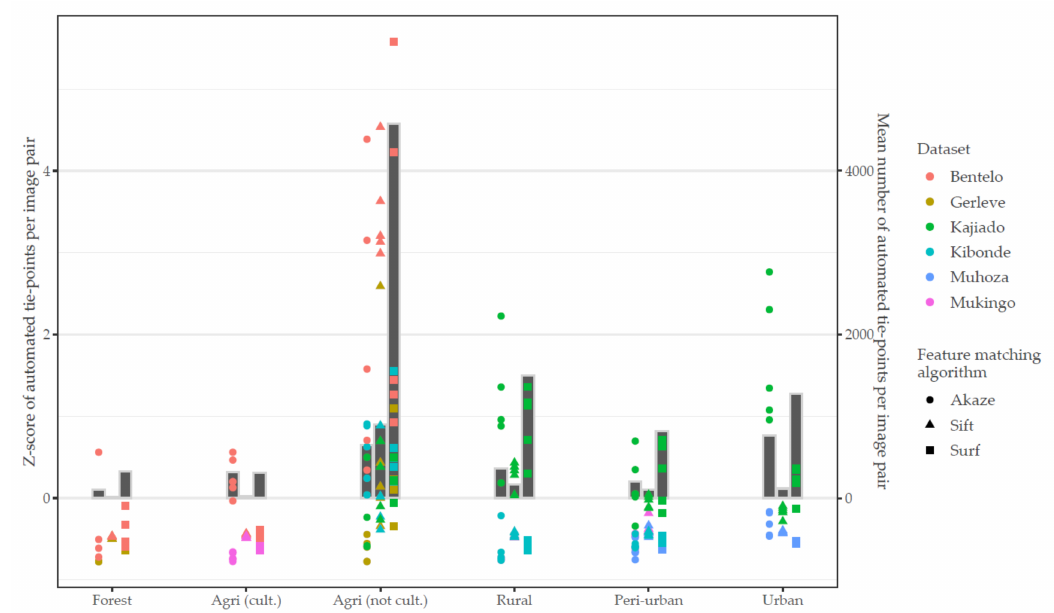
Figure 6. Standardized values of automatic tie-points using SIFT, AKAZE, and SURF as feature extraction, detection, and matching algorithm. The mean number of automatic tie-points per algorithm and land use class is reflected as bars. The x -axis represents land use classes as defined in Table